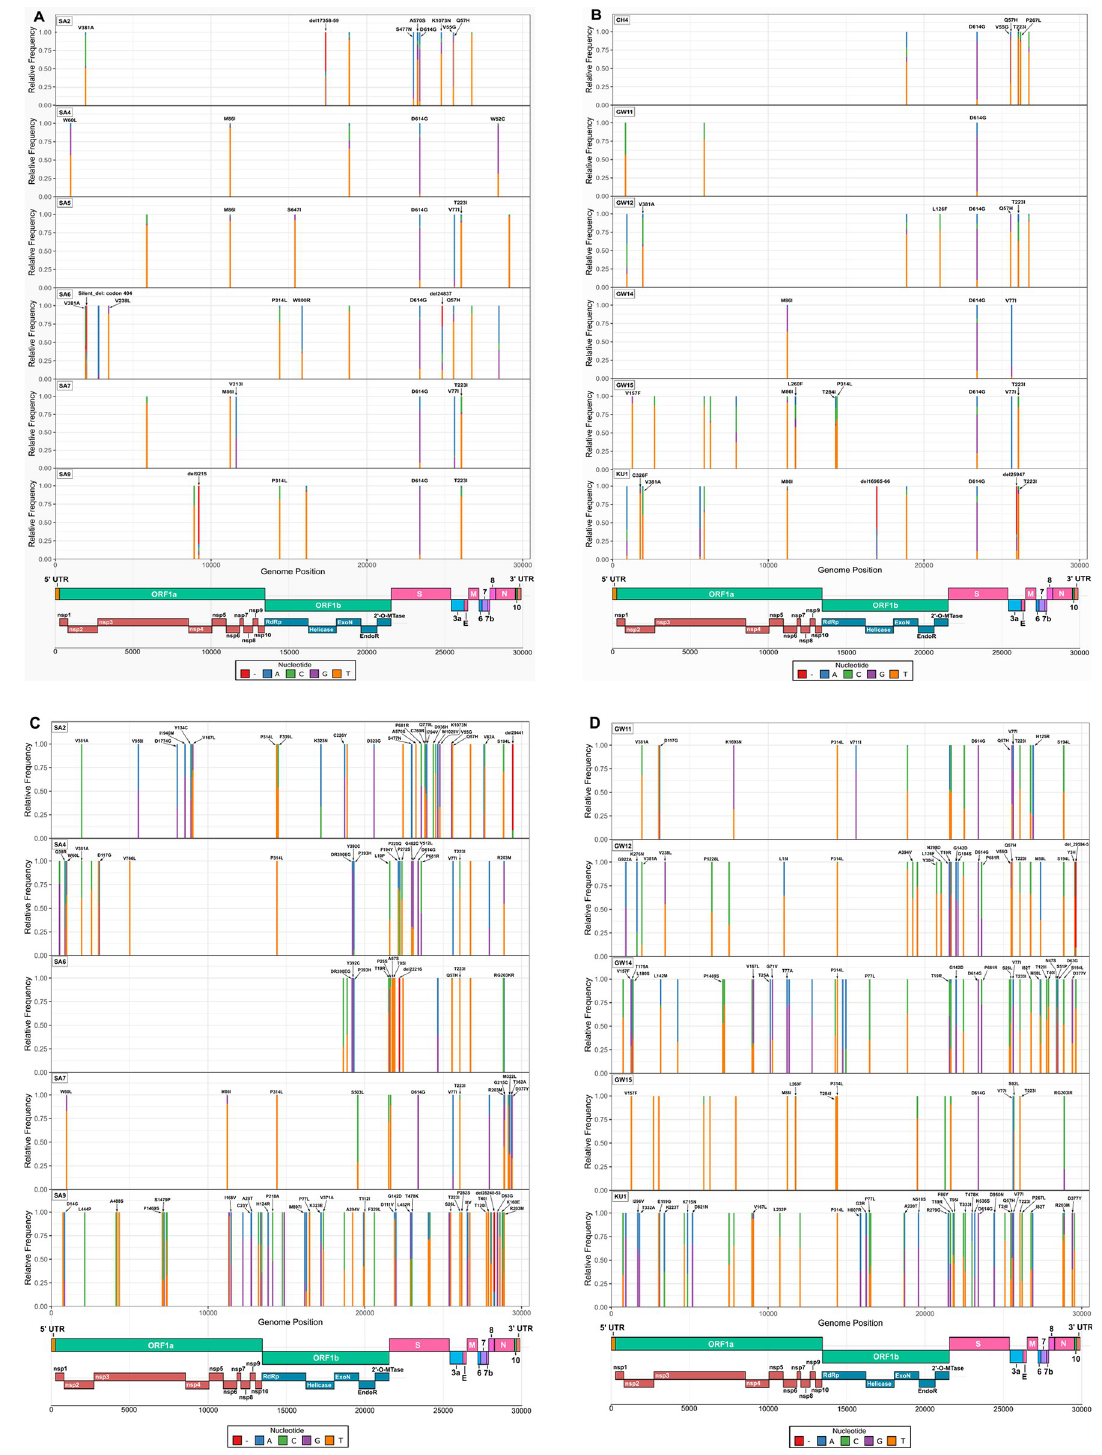
Fig 4. Key Distribution of mutations, both synonymous and nonsynonymous, including nucleotide deletions across the full- length genomes of SARS-CoV-2 from wastewater samples collected in this study. Nucleotide frequencies at each nucleotide position of the mutations are indicated with different colors (shown in key) to show nucleotide variation in the reads generated during sequencing, obtained using Geneious Prime 2020.2.3. (A, B) indicates nucleotide frequency of mutations, generated during Nanopore MinION sequencing of the 12 wastewater samples collected in the study. (C, D) indicates nucleotide frequency of mutations, generated